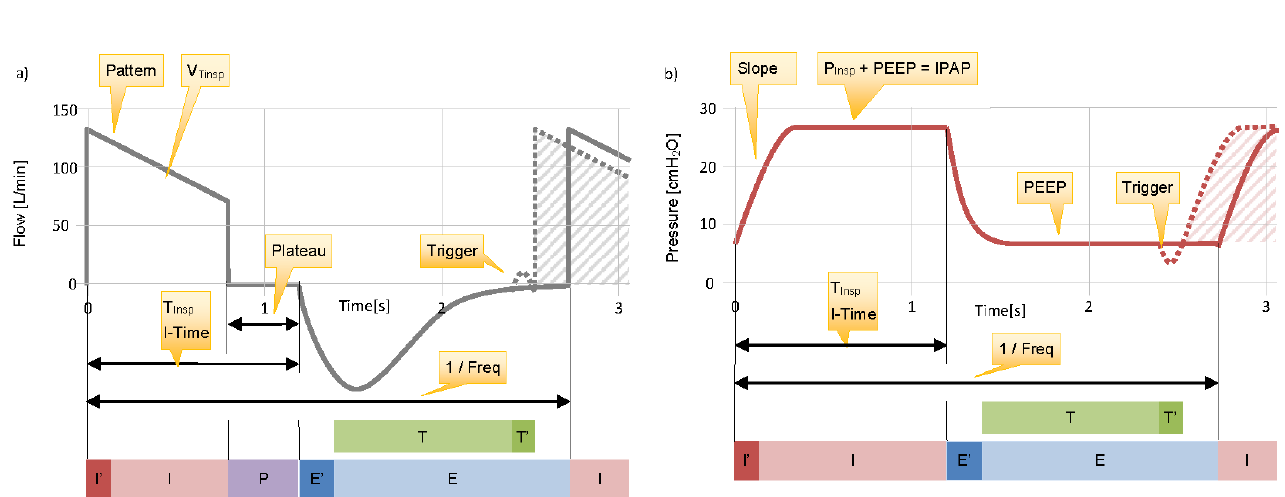
Figure 3. Relationships between ventilation parameters in ( a ) volume-controlled and ( b ) pressure-controlled ventilation mode in relation to the ventilation phases of (I’) minimal inspiration time, (I) inspiration, (E’) minimal exhalation time, (E) exhalation, (T) waiting for a trigger (T’) trigger action and (P) plateau phase. The main ventilation parameters are depicted as well, including slope, PEEP, T insp and f as well as a schematic representation of a trigger event in the pressure and flow regime (taken and adapted from [45])